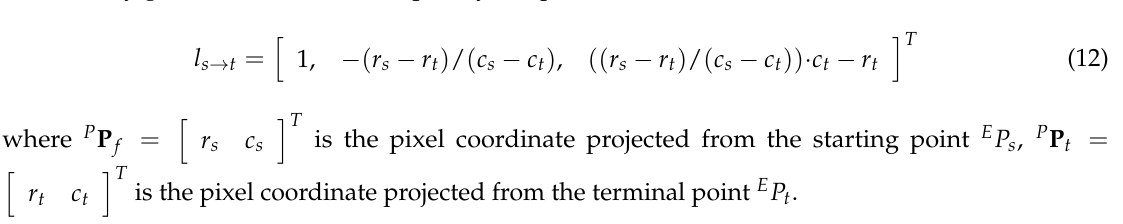
Figure 6. Real Runway Detection: the black solid rectangle is the runway ROI, the red lines are the extracted line segments, the blue quadrangle is the synthetic runway contour, the black dashed rectangles are the neighborhoods of runway edges, and the green quadrangle is the fitted runway edge.